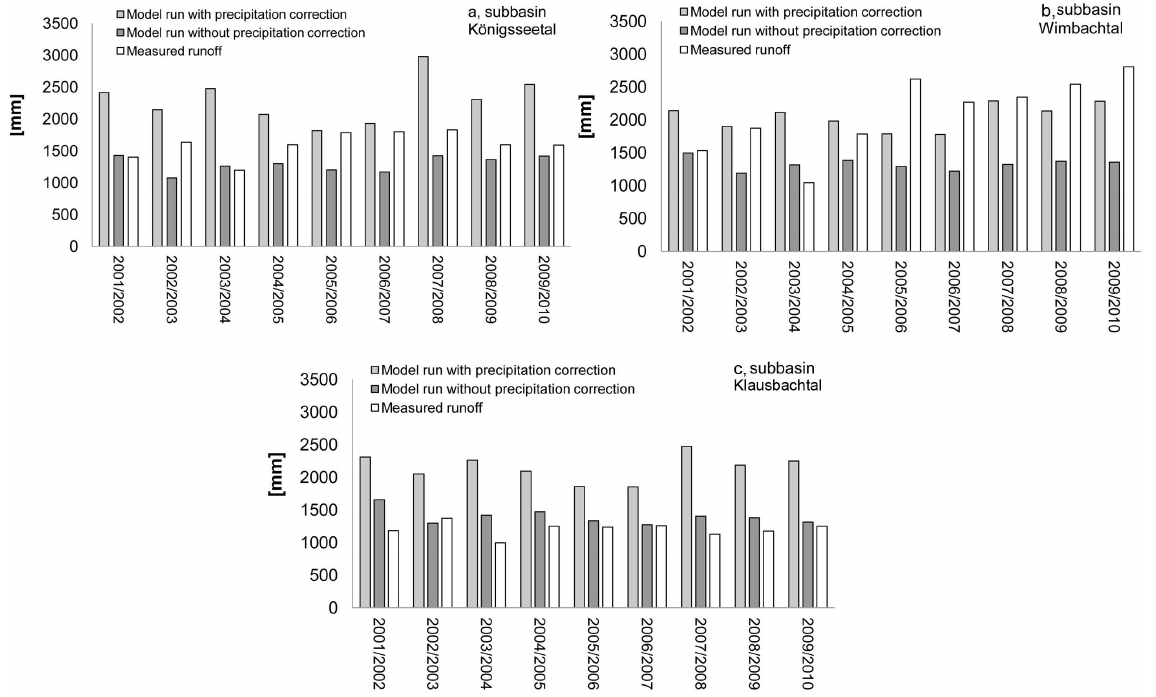
Fig. 6. Annual sums of measured runoff, modeled runoff and modeled runoff with precipitation correction for subbasins Klausbachtal, Wimbachtal and